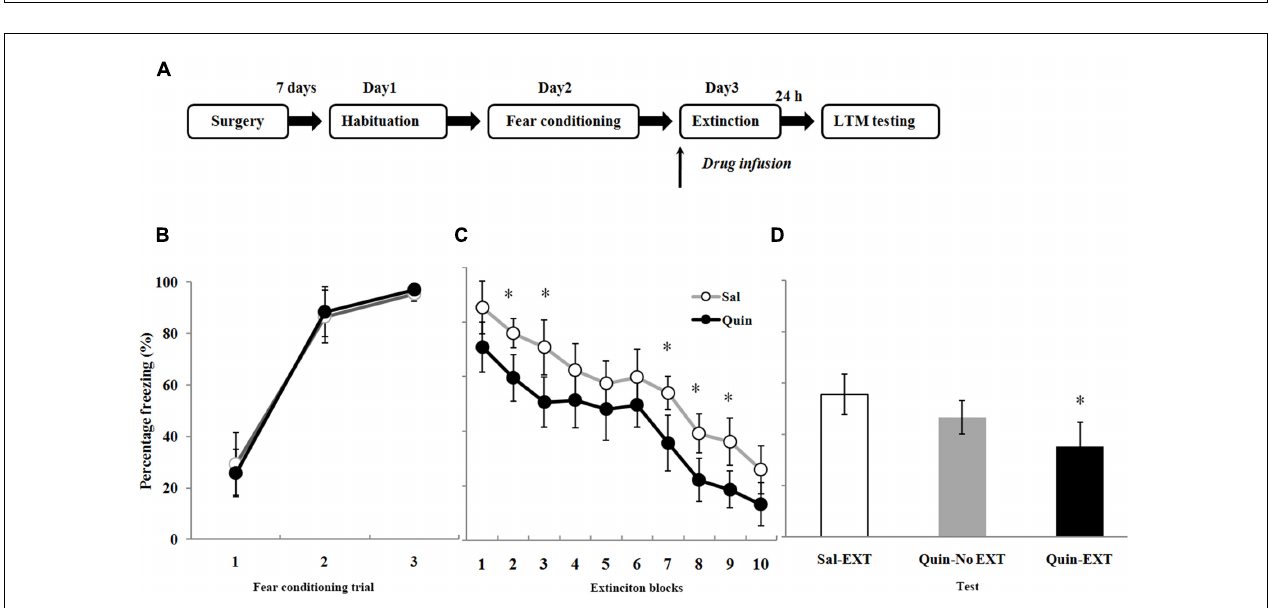
FIGURE 3 | Effects of the optimal doses of sulpiride and quinpirole on locomotion. Rats were injected with saline ( n = 6), quinpirole ( n = 6) or sulpiride ( n = 6) before being placed in the open field for 1 h on Day 1. On Day 2, they were returned, drug free, to the open field.